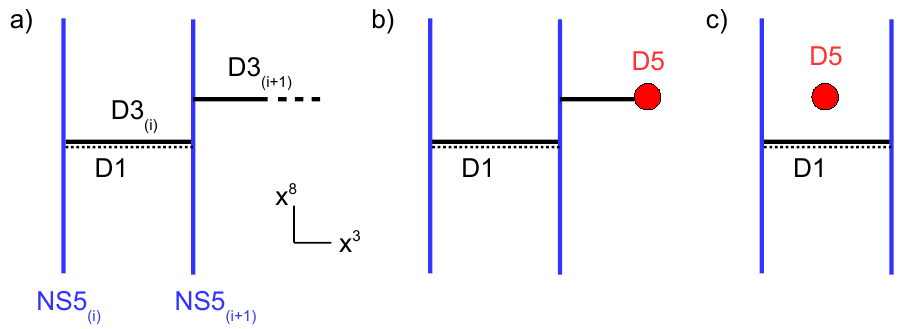
Figure 26 . The local setup (a) with an external D3 segment is related to the setup (c) with a D5 brane by letting the D3 segment end on a D5 (b) and moving it between the two NS5s. The distance between the D5 and the D3 along x 8 + ix 9 is ’ i +1 (cid:0) ’ i